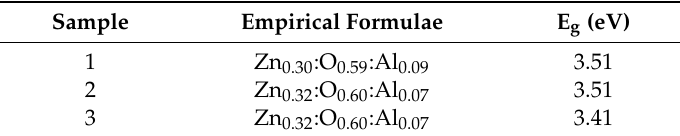
Table 2. Empirical formulae and optical band gap for AZO films.